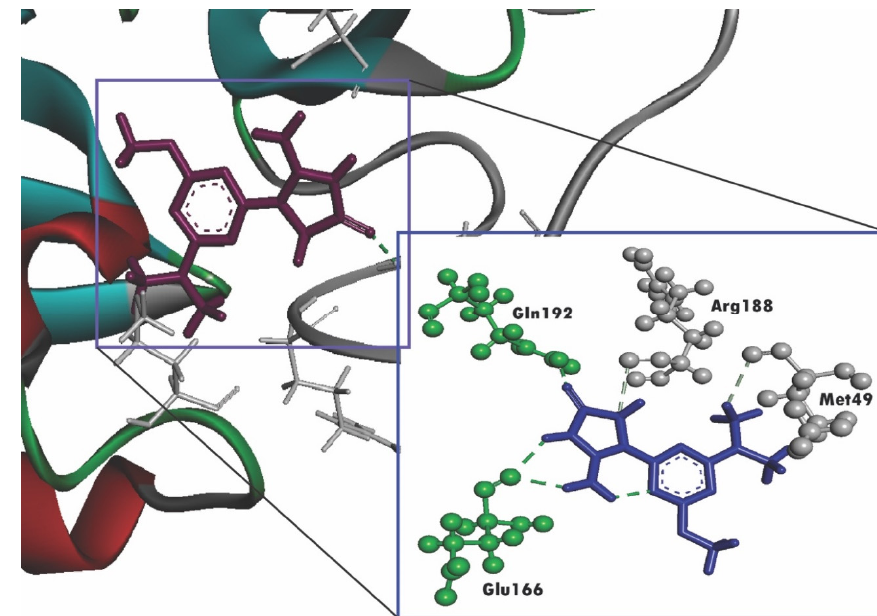
Figure 3. Molecular docking interaction between the SARS-CoV-2 M pro and imidazolidin-4-one, 2- imino-1-(4-methoxy-6-dimethylamino-1,3,5-triazin-2-yl). The ligand in the active site is shown in purple color and the ligand interacting with the residues is shown in blue color, green color illustrates the residues forming hydrogen bonds, and white color illustrates the residues with carbon–hydrogen interaction.